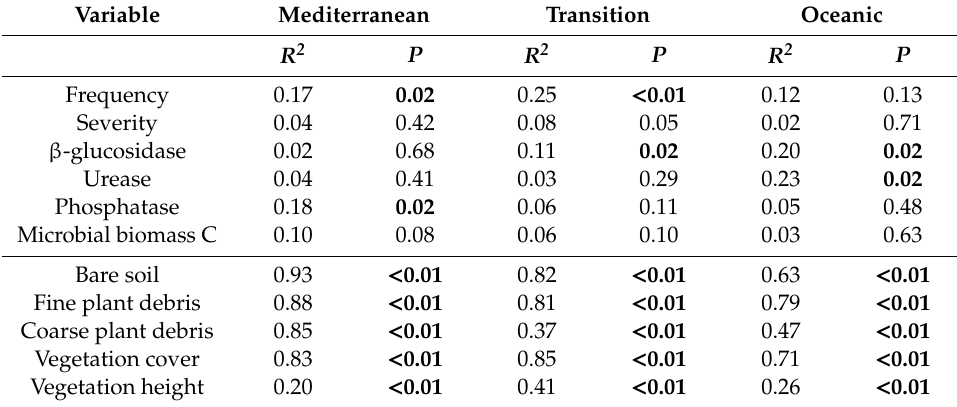
Significant P -values are shown in a bold